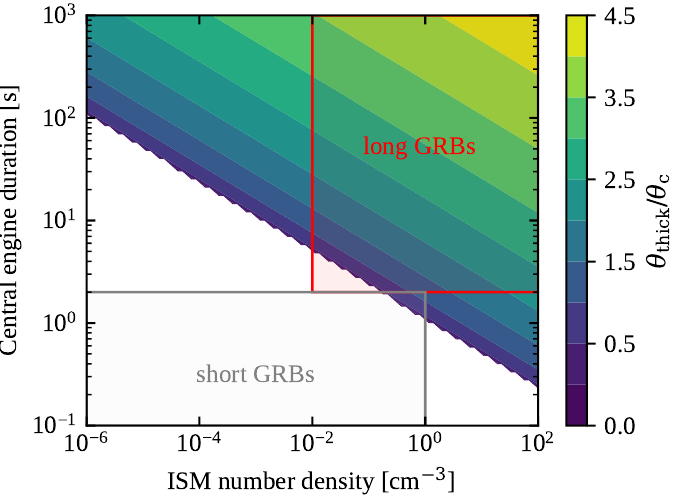
Figure 8. Angle θ thick within which the deceleration takes place in the thick shell regime, in units of the core angle θ c , in a structured jet with Gaussian energy d E /d Ω ( θ ) and bulk Lorentz factor Γ ( θ ) profiles ∝ exp ( − ( θ / θ c ) 2 /2 ) , assuming 4 π d E /d Ω ( 0 ) = 10 54 erg and Γ ( 0 ) = 1000, as a function of the ISM number density n and central engine duration T CE . Boxes show the regions of the plane where most long (red box) and short (grey box) GRBs are expected to